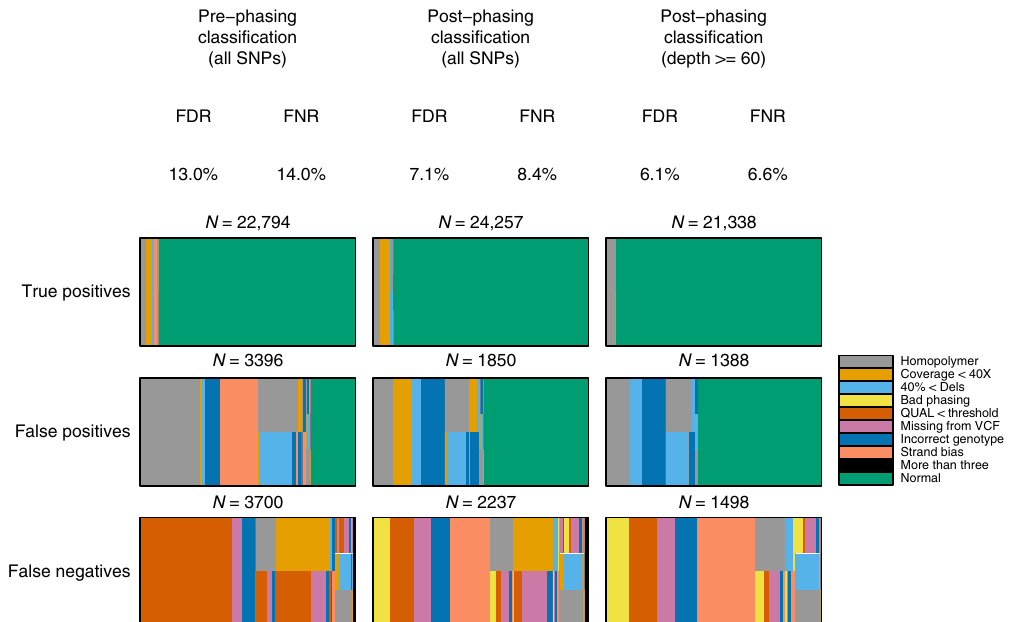
Fig. 2 Investigation of residual errors in NA12878 data. Annotation of called or truth SNPs using genomic features or sequencing context in NA12878. Results across columns give the different sets of SNPs, either pre or post-phasing, and for post-phasing, optionally all SNPs or those at high local depth ( > = 60× coverage). Results across rows give SNP classes of true positives, false positives and false negatives. Bars are broken horizontally to re fl ect multiple possible annotations, while vertical splits represent SNPs with multiple annotations. Annotations are: homopolymer, SNP intersects a homopolymer of length at least 5 bases; Coverage <40×, per-base coverage of less than 40×; 40%<Dels, at least 40% of reads have deletions at that SNP; Bad phasing, the quality control phasing metric for that SNP was below threshold; QUAL < threshold, the quality score for the SNP was below threshold; Missing from VCF, there was insuf fi cient evidence from the variant caller to put this variant in the output VCF; Incorrect genotype, disagreement between truth and called genotype; Strand bias, Freebayes metrics SRP or SAP < 30; More than three, more than three of the above annotations; Normal,